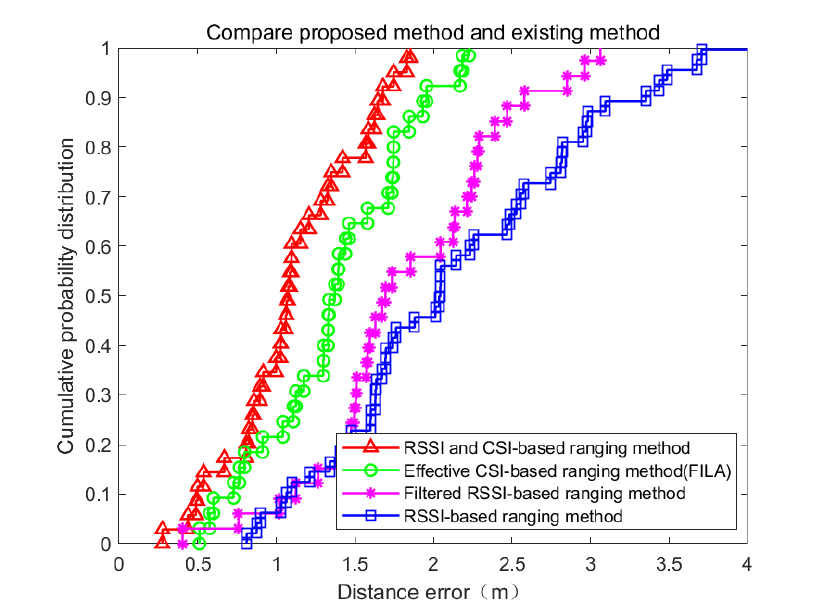
Figure 18. CDF of distance errors with the four ranging algorithms in IT-1